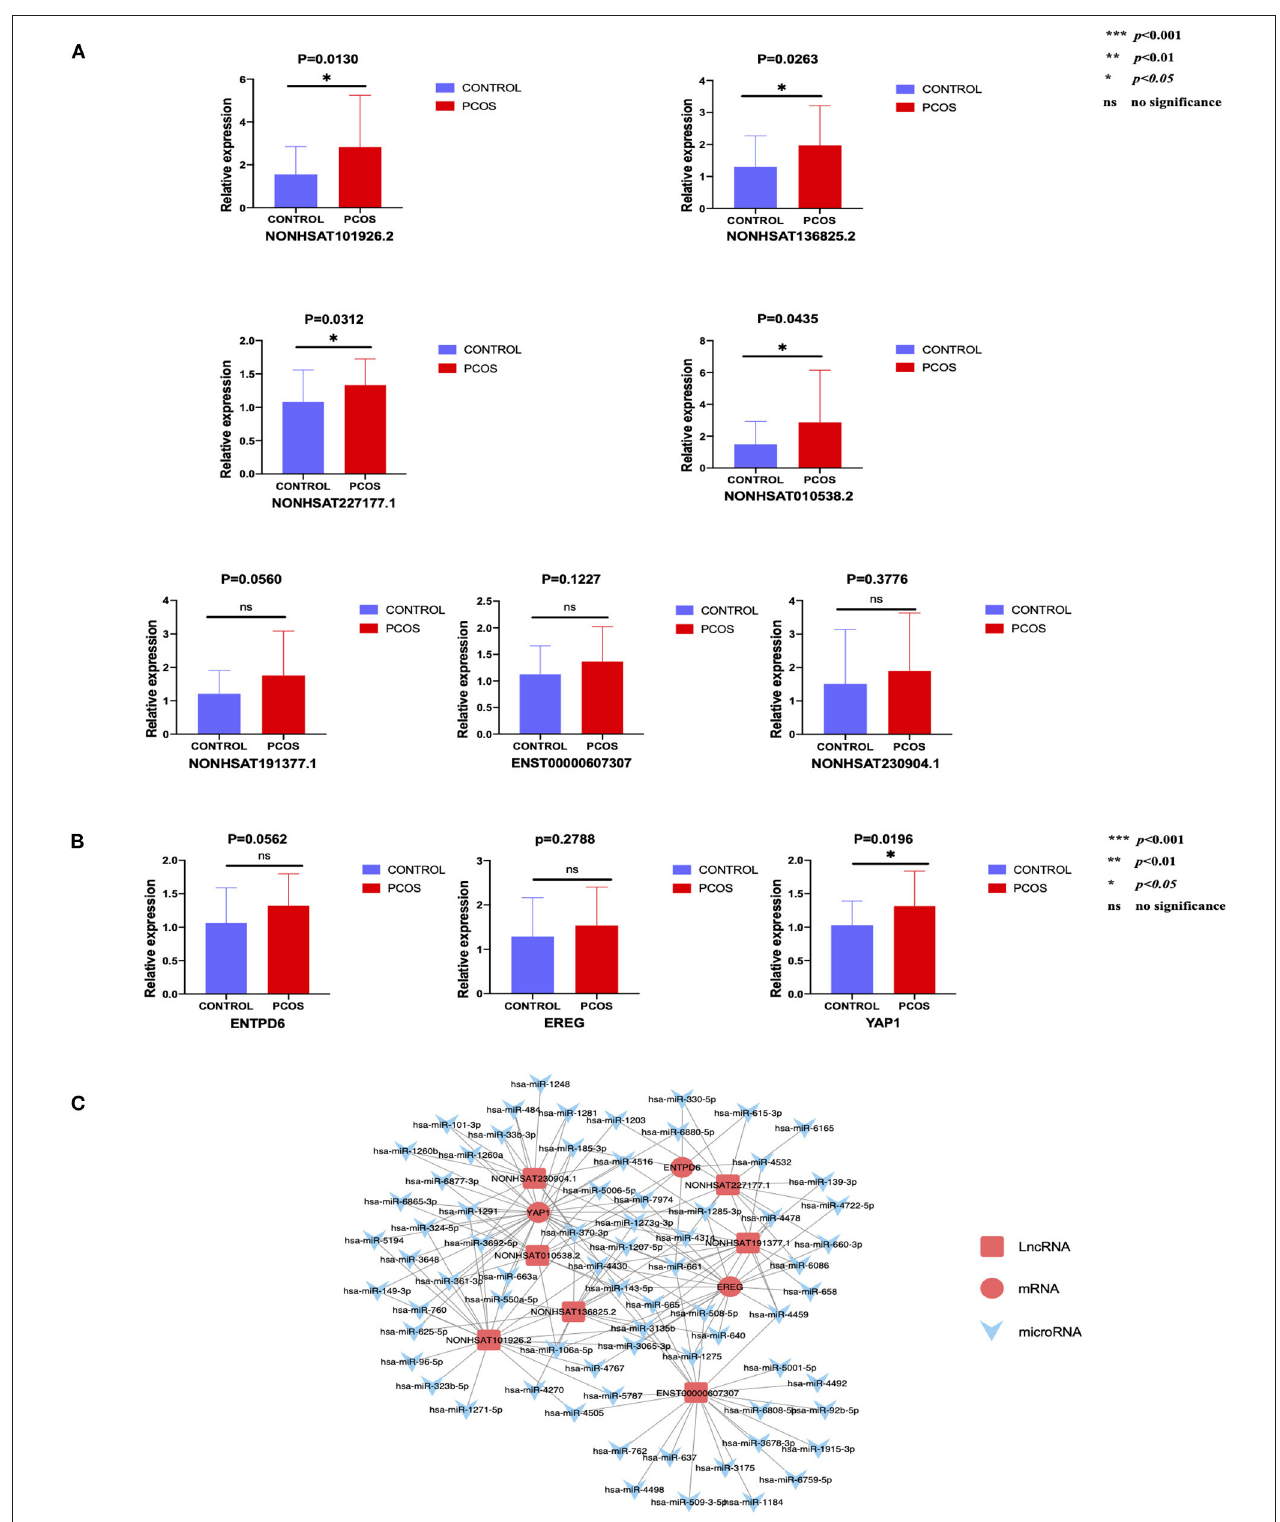
FIGURE 2 | The expression level of lncRNAs and mRNAs conforming to the sequencing results and the predicted network regulatory relationship between them. (A) 7 lncRNAs that meet the trend of sequencing results. (B) 3 mRNAs that meet the trend of sequencing results. (C) Possible regulatory relationship between lncRNAs and